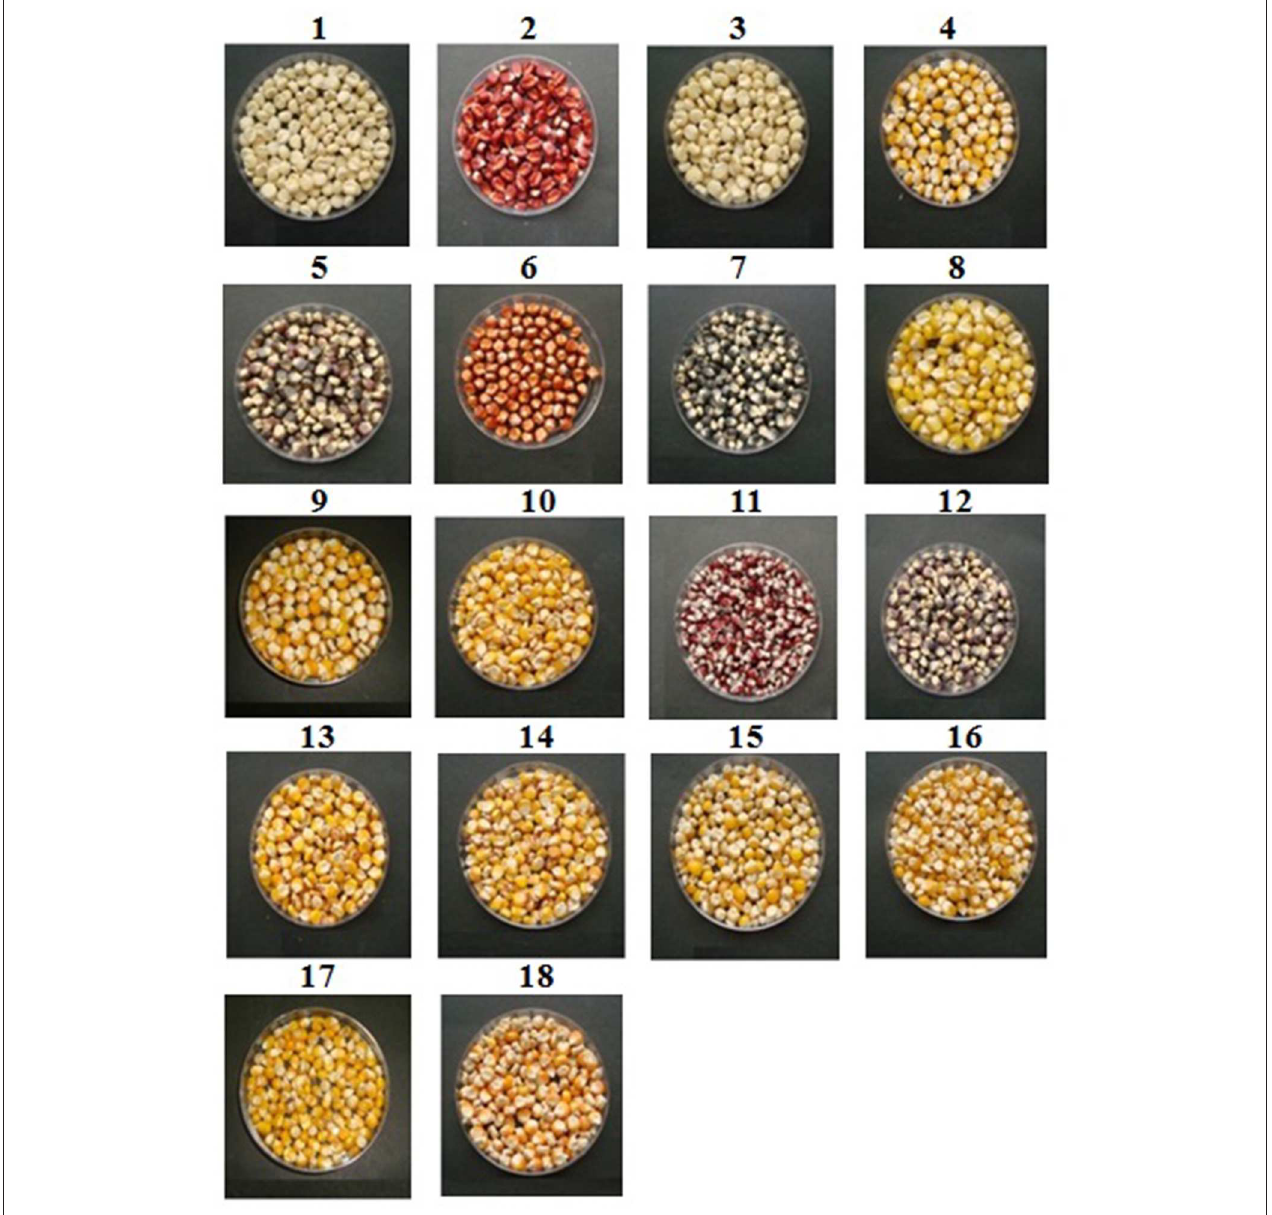
FIGURE 1 | Kernel color variation in NEH maize landraces. (1) CAU-M 1, (2) CAU-M 3, (3) CAU-M 5, (4) CAU-M 12, (5) CAU-M 13, (6) CAU-M 16, (7) CAU-M 19, (8) CAU-M 20, (9) CAU-M 24, (10) CAU-M 26, (11) CAU-M 27, (12) CAU-M 28, (13) CAU-M 31, (14) CAU-M 36, (15) CAU-M 52, (16) CAU-M 53, (17) CAU-M 60, (18) CAU-M